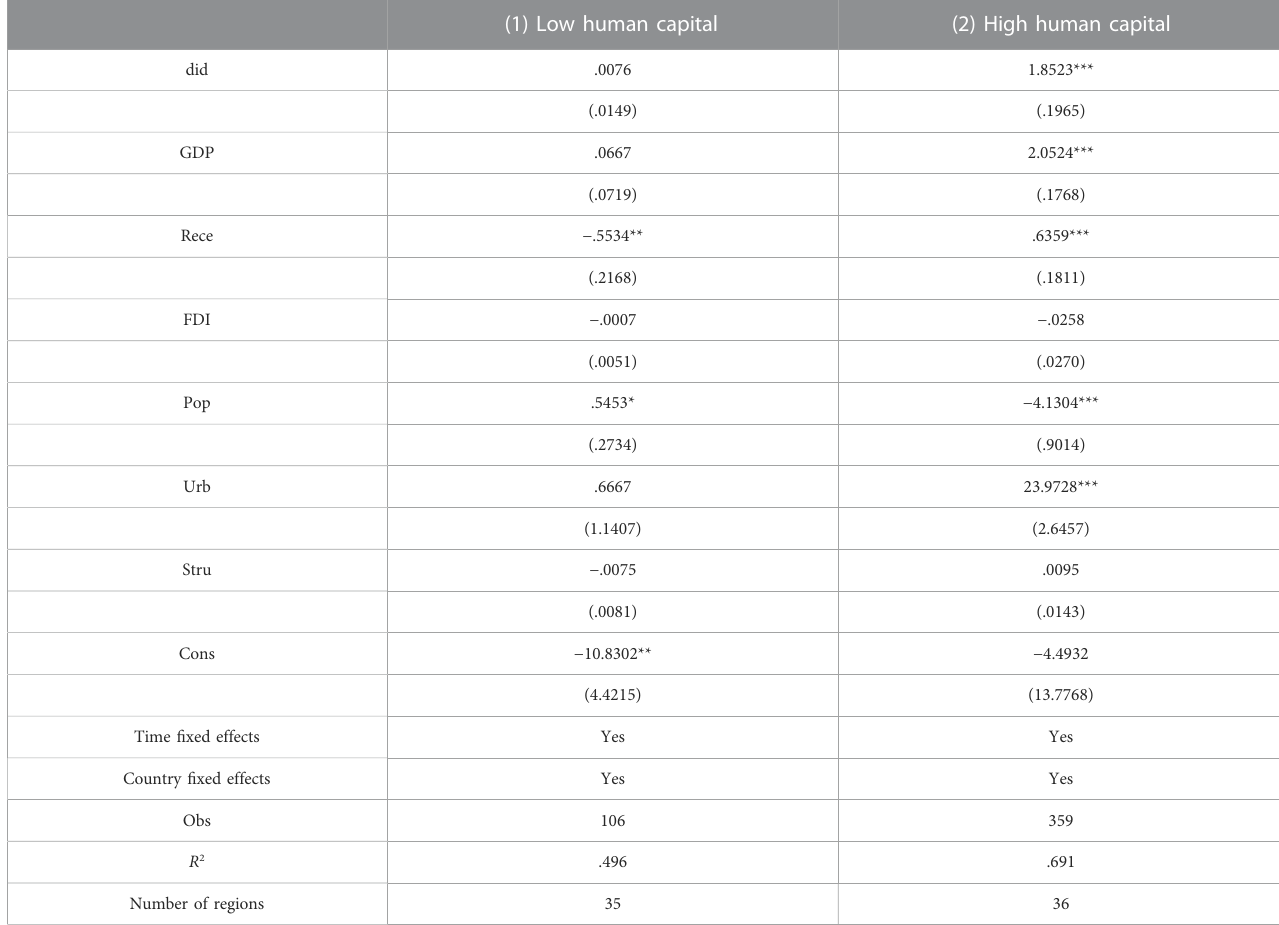
TABLE 6 Heterogeneity test of human capital.